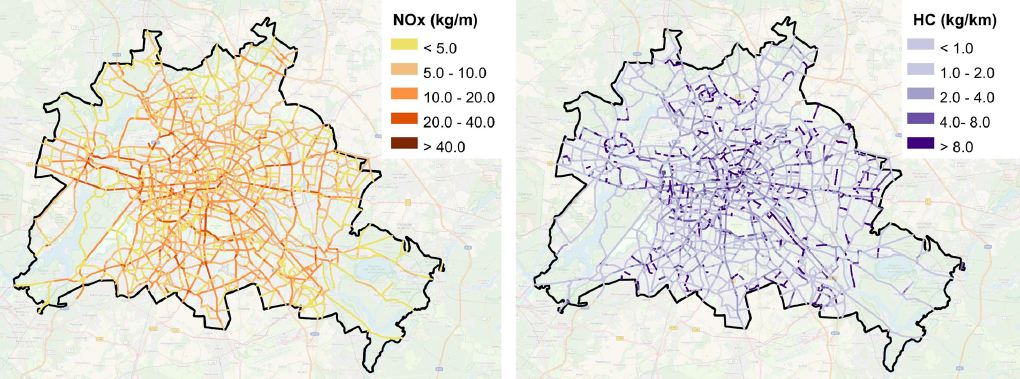
Figure 5. Distributions of annual daily mean of (left) NO x and (right) HC emissions [kgm − 1 ] for 2015 from Yeti using HBEFA 3.3 emission factors over the Berlin road network (background overlay © Google Maps